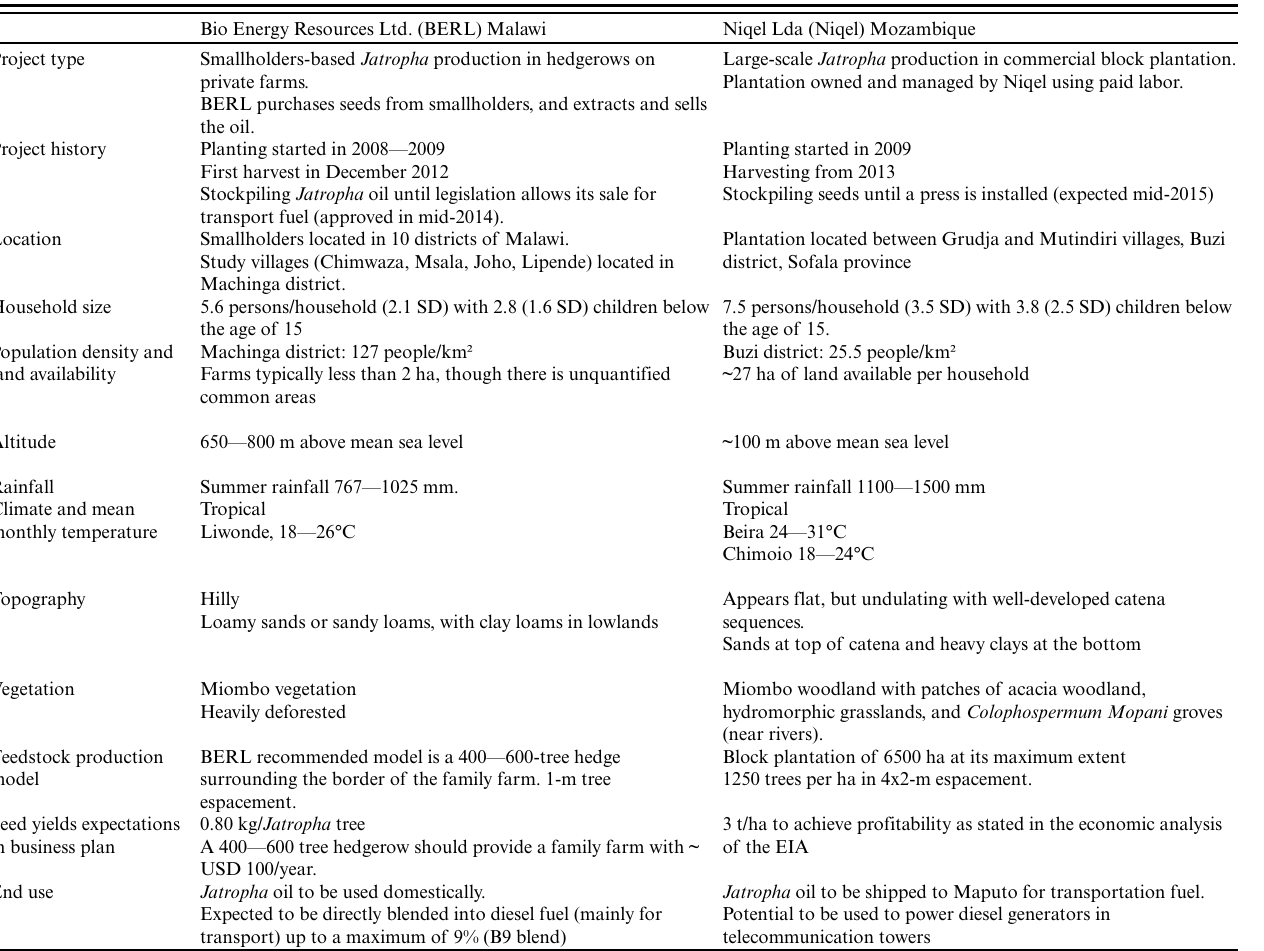
Table 3 . Key characteristics of the Niqel and BERL Jatropha projects †